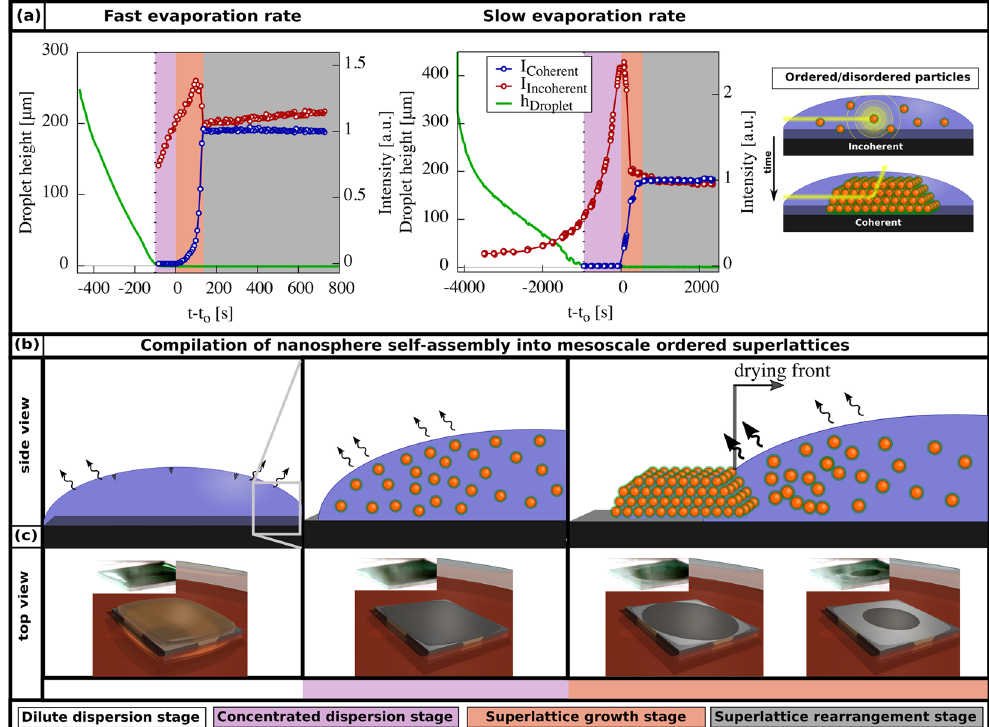
Figure 5. Time-dependent GISAXS scattering intensity information and drying behaviour identify the temporal transitions during drop casting. ( a ) Time-dependent evolution of the coherent and incoherent scattering intensity together with the height of the droplet for the slow and fast evaporation rate experiments. The major stages during drop casting are indicated by the colored regions in the background. The value t 0 describes the onset of superlattice formation, i.e. the time when a detectable coherent intensity first evolves. ( b ) Schematic illustration of how the transition from a concentrated dispersion to the onset of superlattice formation is related to, ( c ) the occurrence and movement of a drying front across the surface of the thin nanoparticle dispersion film. The insets show photos of the top surface of the drying droplet obtained at different times during drop